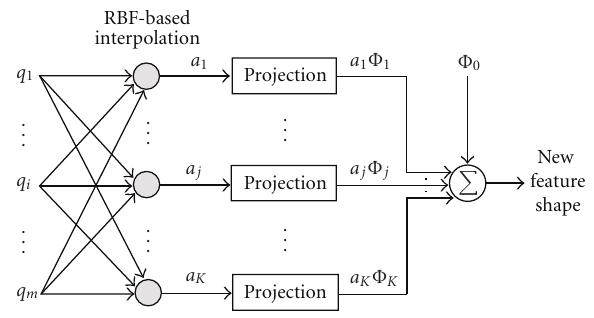
Figure 7: Generating a new facial feature shape by blending exam- ple models through interpolation of their eigenmesh coordinates.